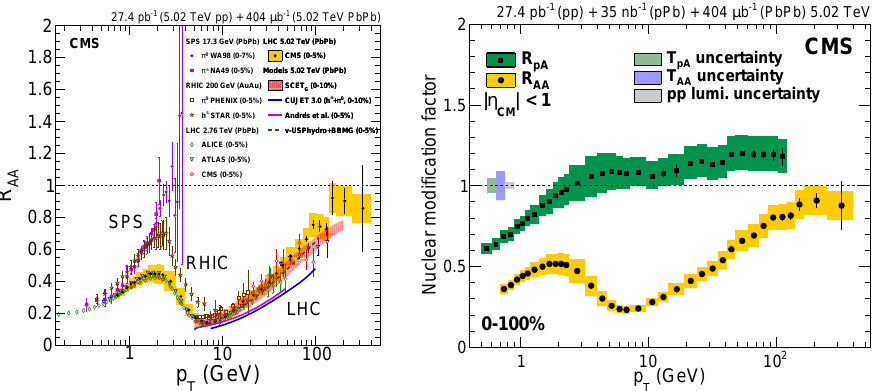
Figure 22. Left : A compilation of the measurements of R AA ( p T ) for neutral pions ( π 0 ), charged hadrons ( h ± ), and charged particles in central heavy-ion collisions at SPS, RHIC, and the LHC. Reproduced from Ref. [334]; Right : The nuclear modification factor R pPb ( p T ) in p + Pb compared to R AA from √ s Pb + Pb collisions at = 5.02 TeV at the LHC. Reproduced from Ref. NN